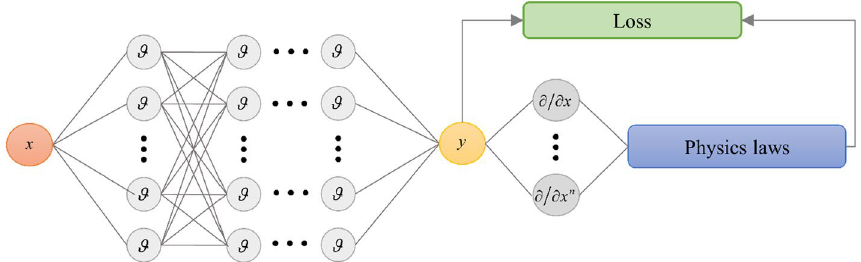
Fig. 22 An illustration of a PINN structure. x and y are respectively the input and output of the neural network. The loss function of a PINN can contain two parts, namely the data‑driven loss term and the physics law loss term. The output of the neural network can be directly compared to the ground truth data, which results in the data‑driven loss term. In addition, the output of the neural network can be also substituted